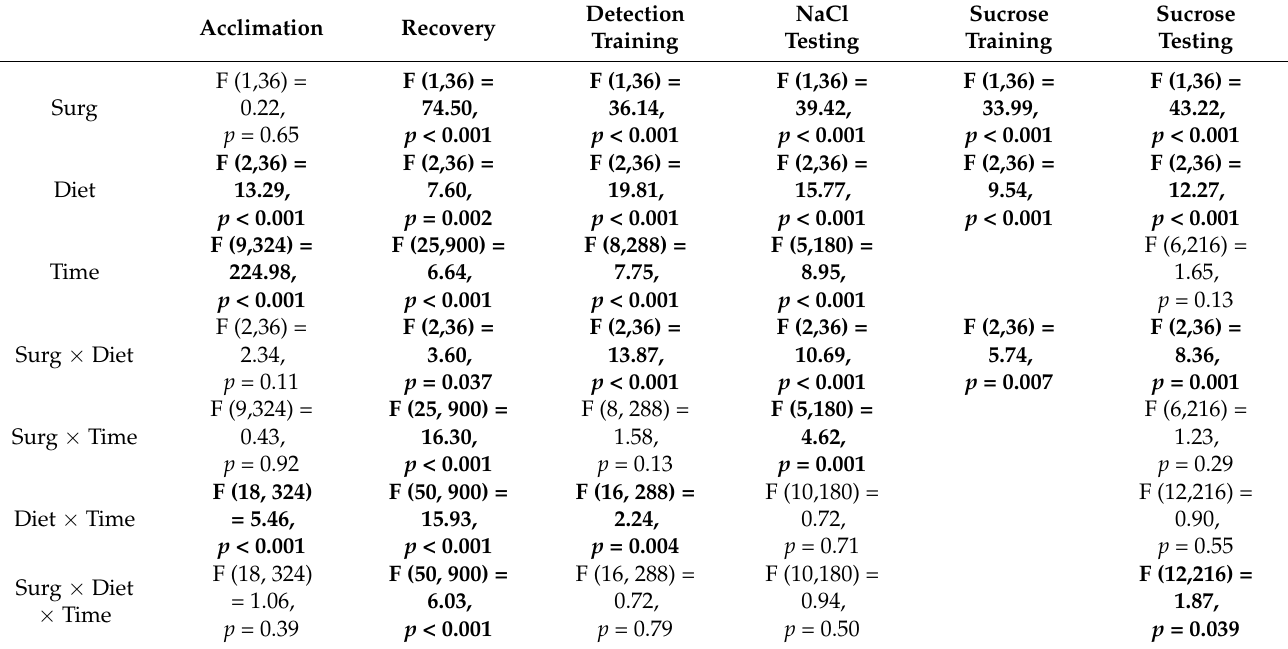
Table 4. Statistical analysis from 3-way, repeated measures ANOVA comparing percentage change body weight during the critical testing periods (Figure 3, bottom). Significant values are noted by bold